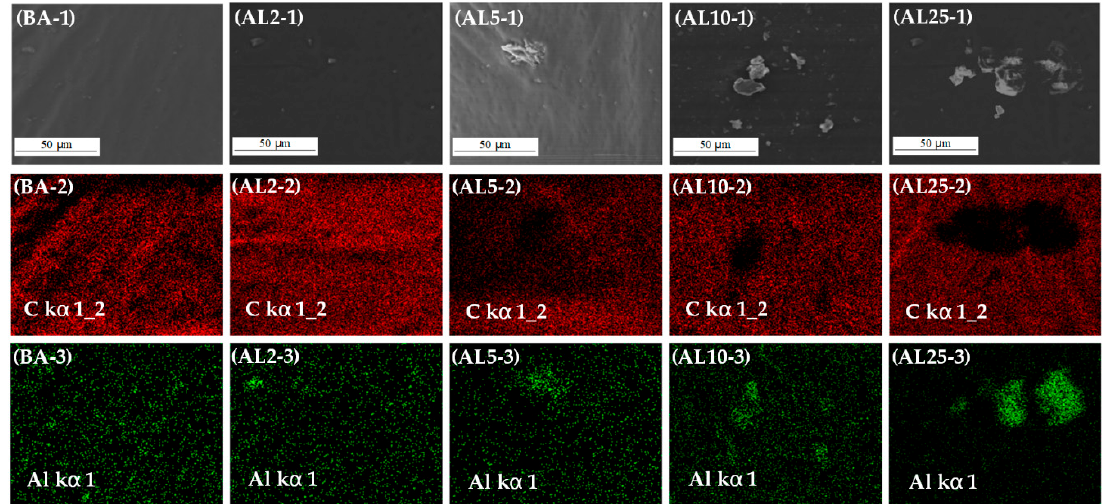
Figure 4. SEM images and EDS element mapping images (C in red and Al in green) of asphalt binders.